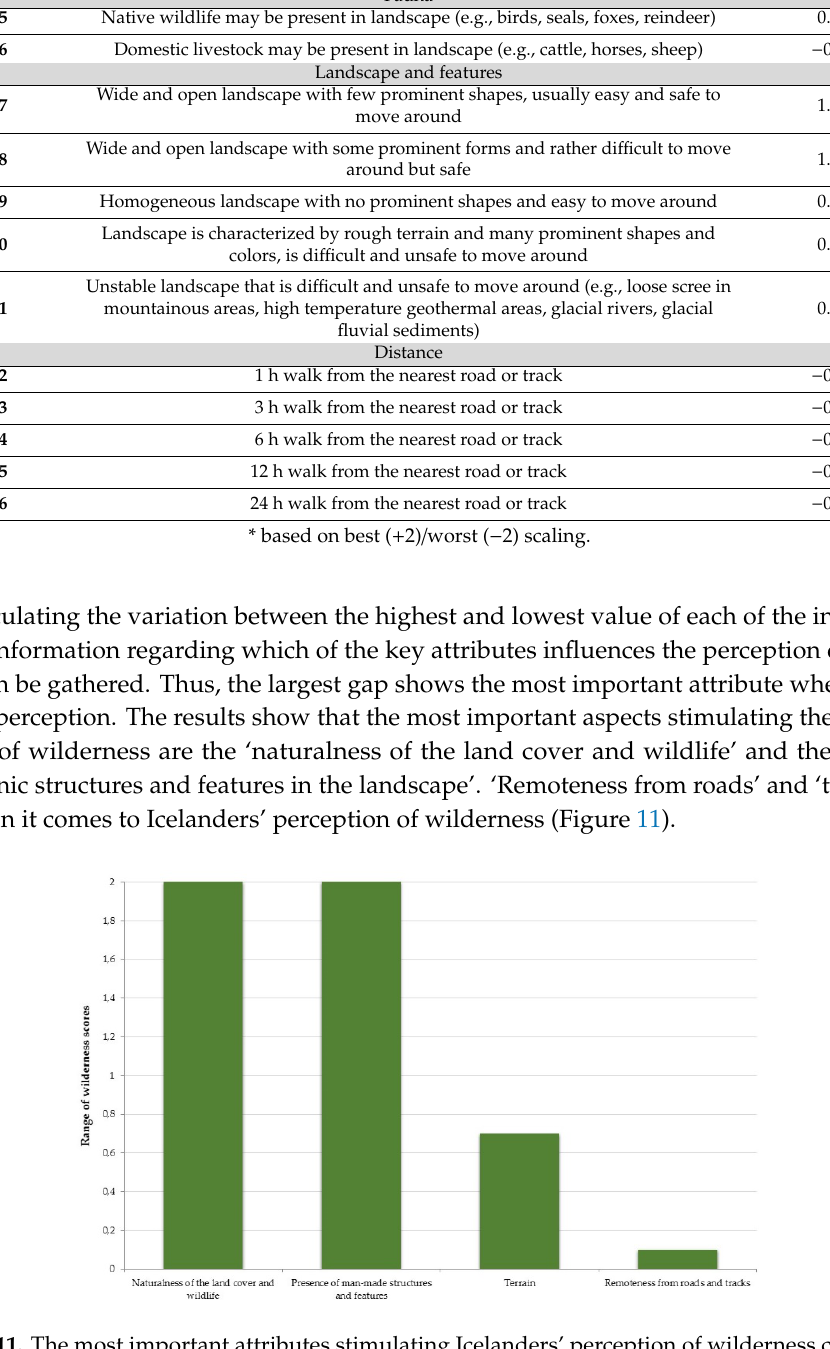
Figure 11. The most important attributes stimulating Icelanders’ perception of wilderness calculated as range of wilderness-scores for each attribute scenario.